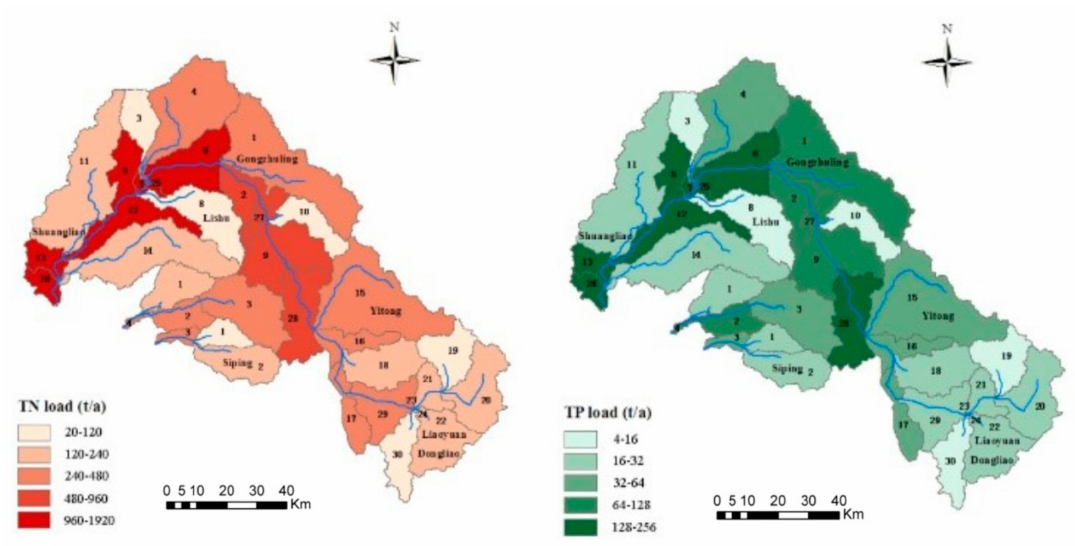
Figure 4. Spatial distribution of TN and TP loads in the source area of Liao River in